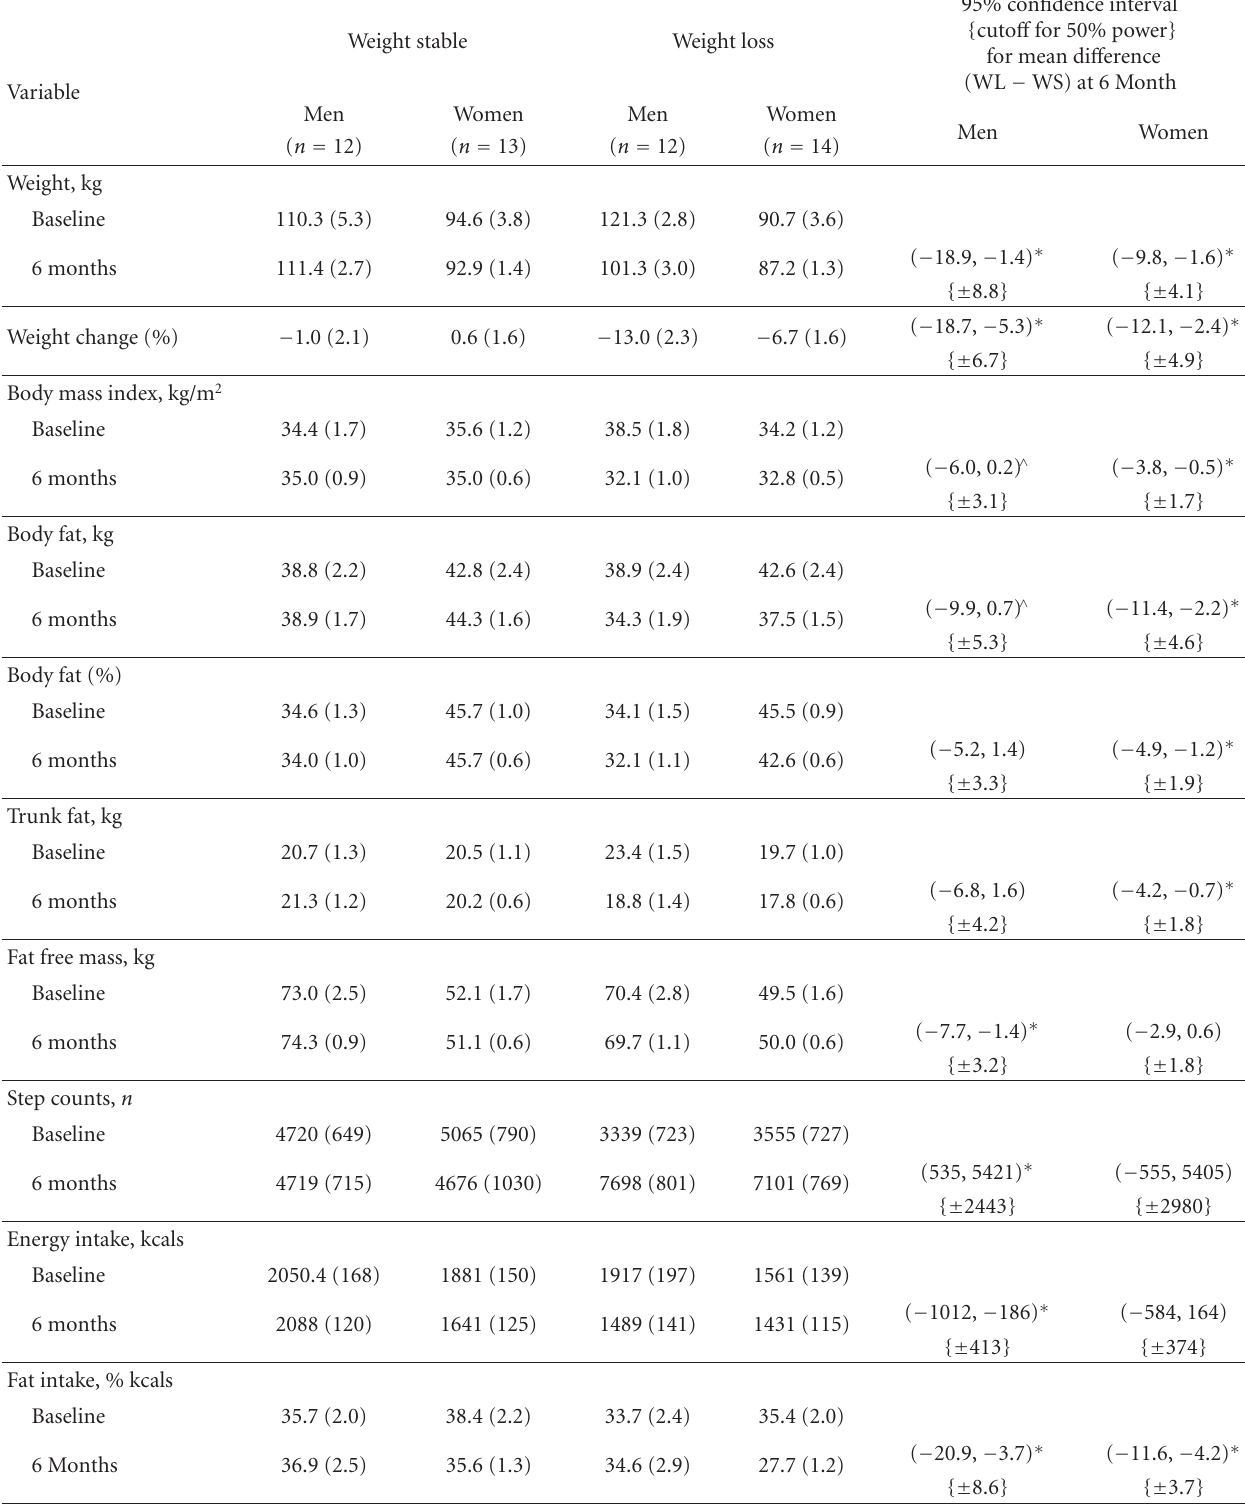
Table 2: Measures of body weight and body composition outcomes and diet and physical activity behaviors at baseline and 6 month followup separated by gender. Statistical analysis was performed on 6 month